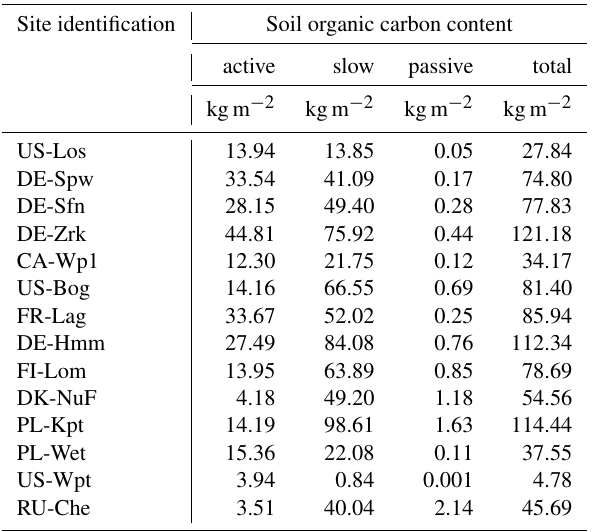
Table 8. Integrated simulated soil organic carbon content of peat- land sites up to 0.75m